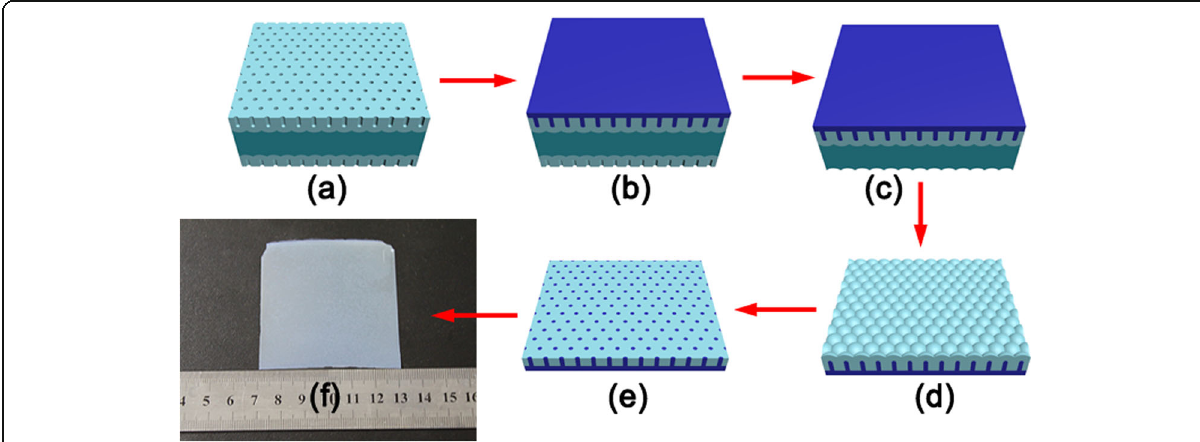
Fig. 1 The fabrication processes of through-pore AAO filter membrane. ( a ) The as-obtained double side AAO on the Al foil. ( b ) Spin-coating a PMMA thin film on the one side. ( c ) Etching off AAO on the back side. ( d ) Removing the Al foil. ( e ) Dissolving the barrier layer in the AAO. (f) Removing the PMMA in glacial acetic acid and obtaining through-pore AAO filter